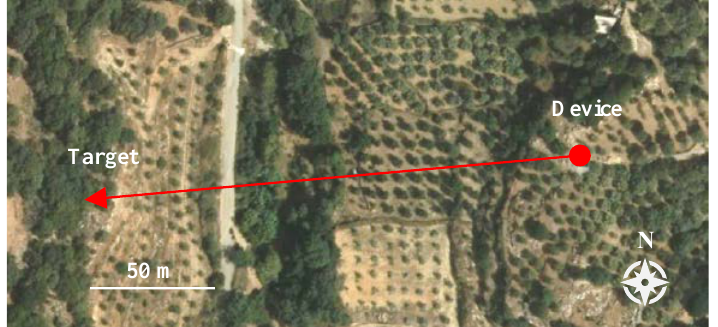
Figure 7. Map of the instrument’s installation location (image from the Hellenic Land Registry [30]).